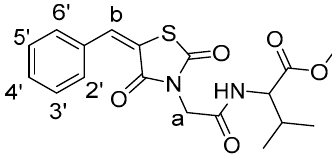
Figure 2. Structure of compound 5g .